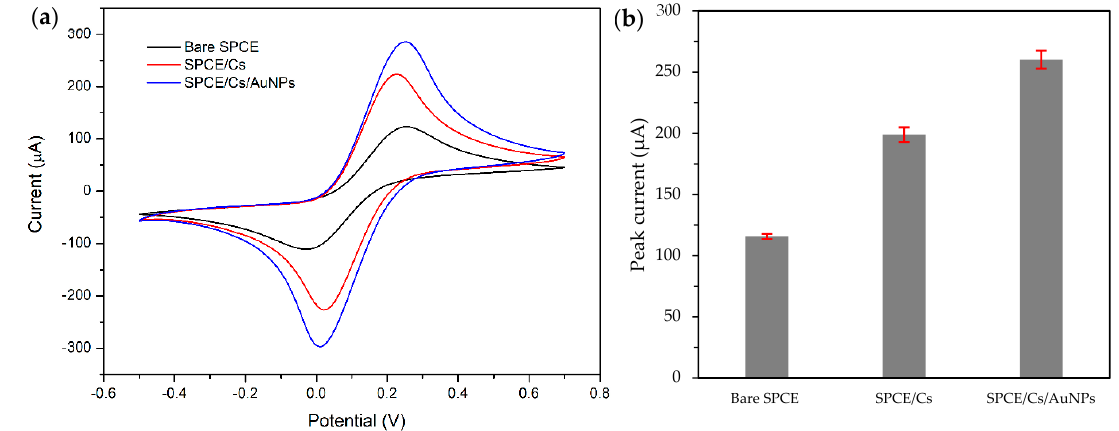
Figure 5. ( a ) Cyclic voltammograms and ( b ) bar graph of bare screen-printed carbon electrode (SPCE), SPCE and chitosan (SPCE/Cs) and SPCE with a mixture of AuNPs and chitosan (SPCE/Cs/AuNPs) (green synthesised) modified electrodes in 5 mM [Fe(CN)6] 3 − /4 − in phosphate buffer saline (PBS).